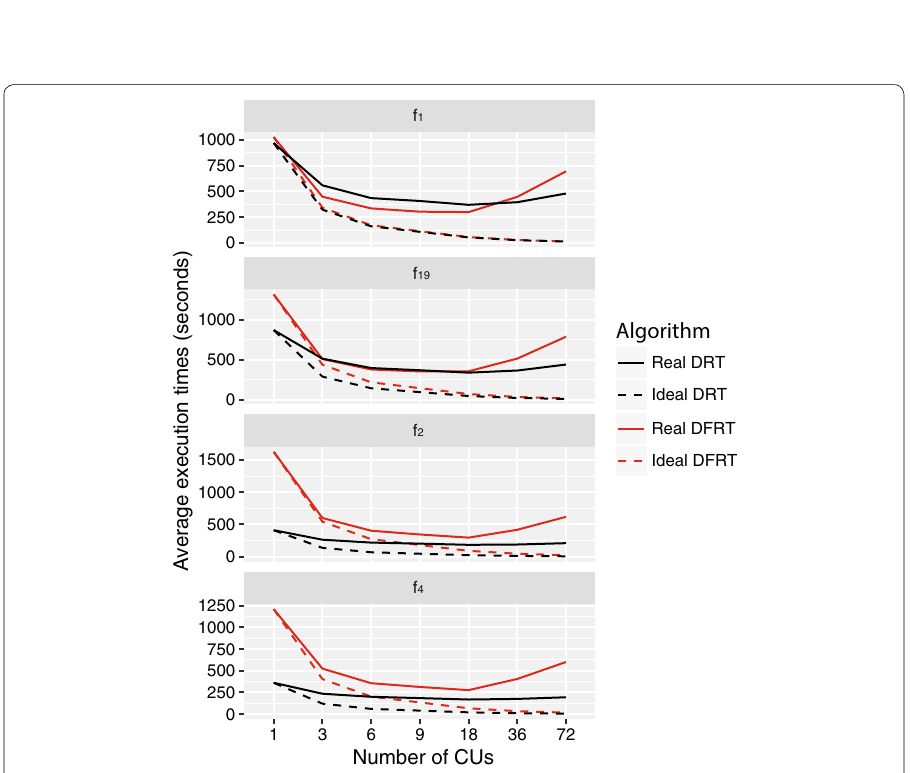
Fig. 6 Average execution times of the DRT and DFRT algorithms for the synthetic datasets versus the number of